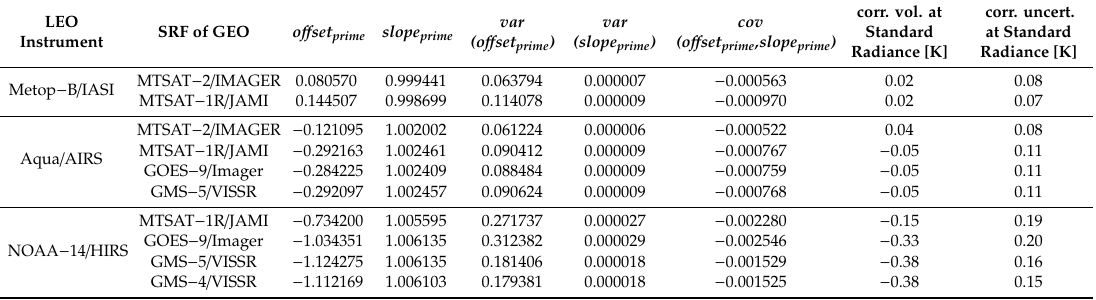
Table A6. Parameters of the prime reference correction for the IR channel (unit: mW / (m 2 sr cm − 1